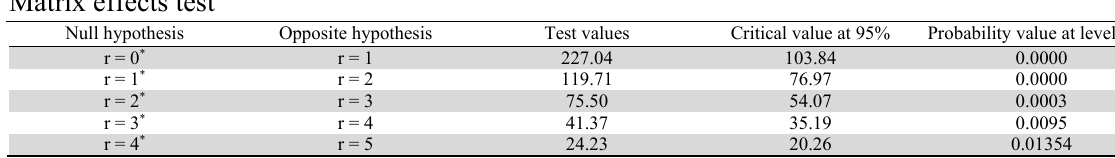
Matrix effects test